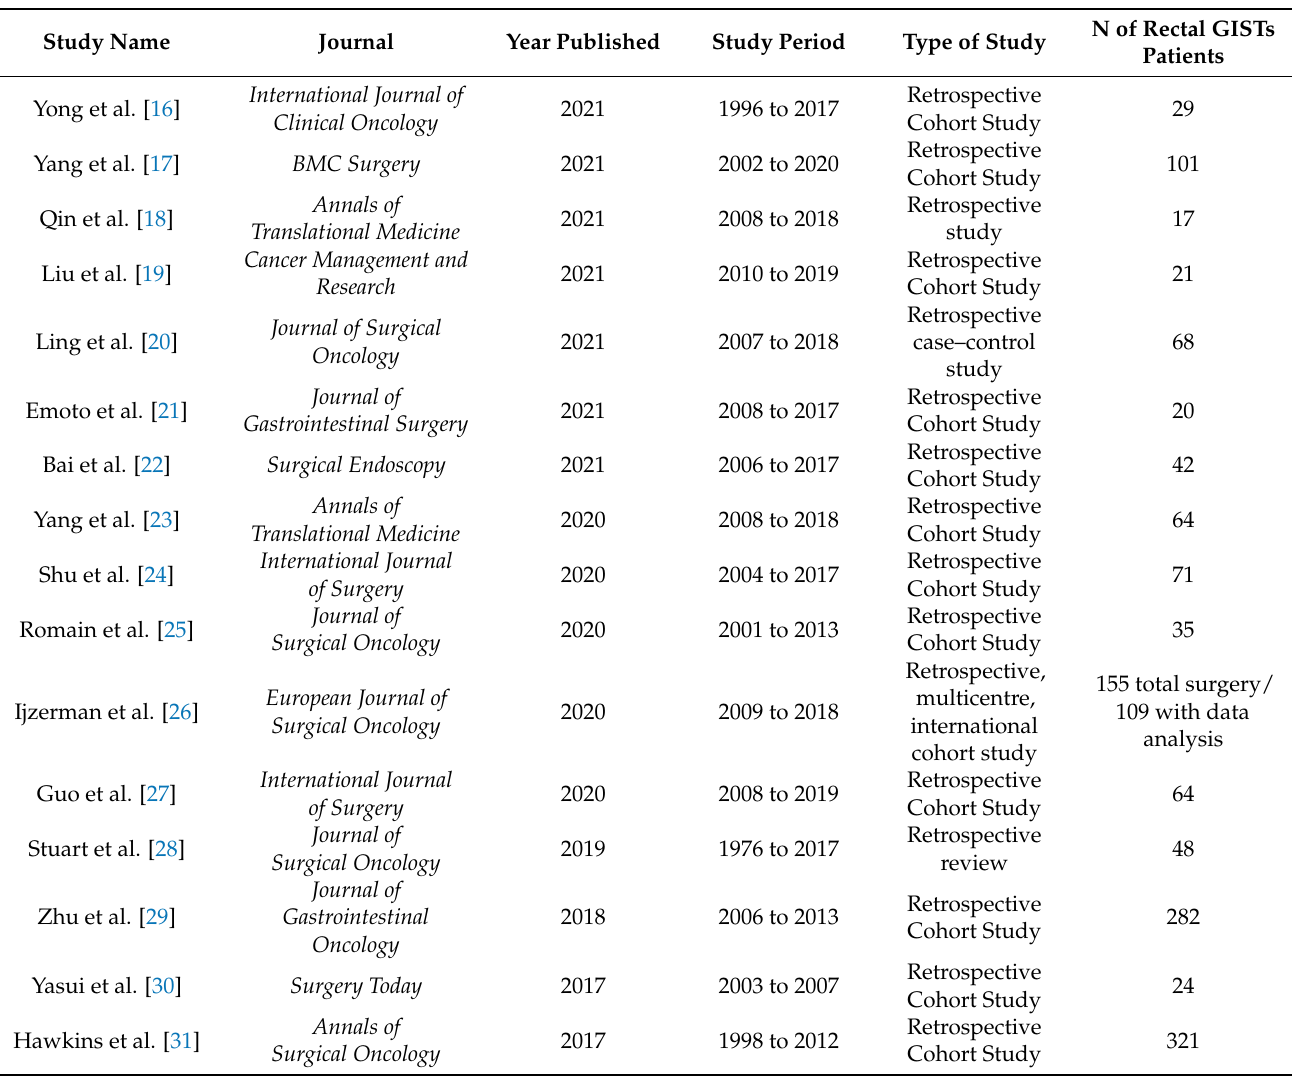
Table 1. Methodological characteristics of the included